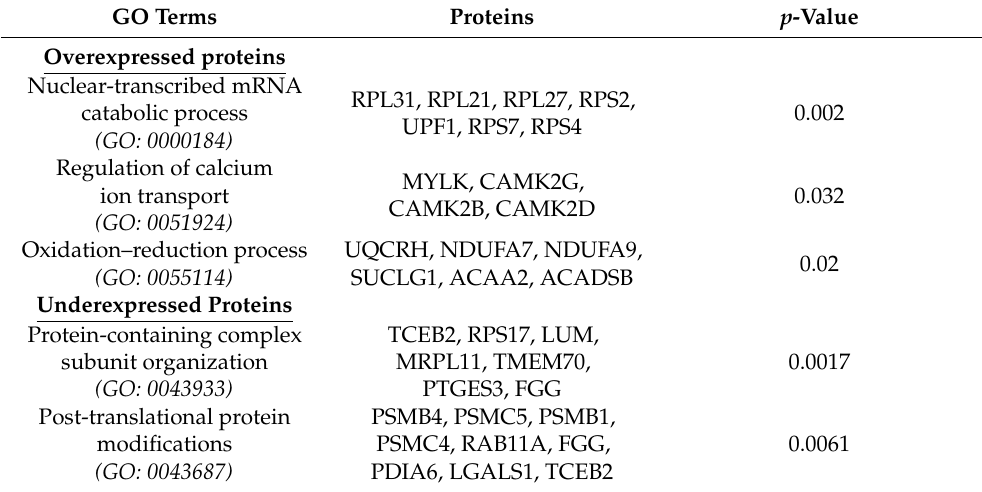
Table 5. Biological processes according to the results of the STRING analysis of overexpressed and underexpressed proteins in the VPG vs.